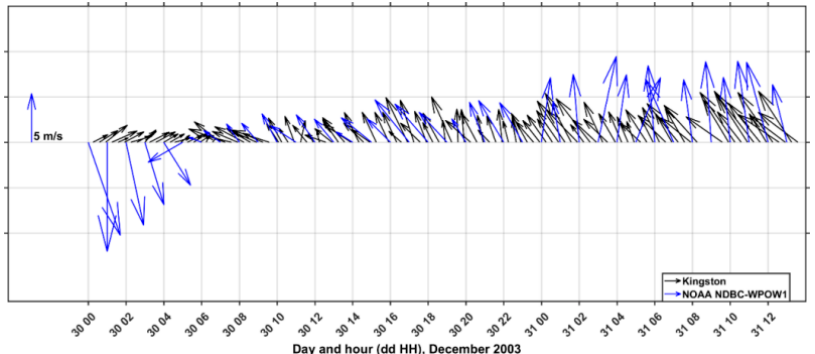
Figure 8. Comparison of wind data from NOAA (NDBD-WPOW1, black vectors) and Kingston (blue vectors) wind stations. The locations of these two stations can be seen in Figure 9.